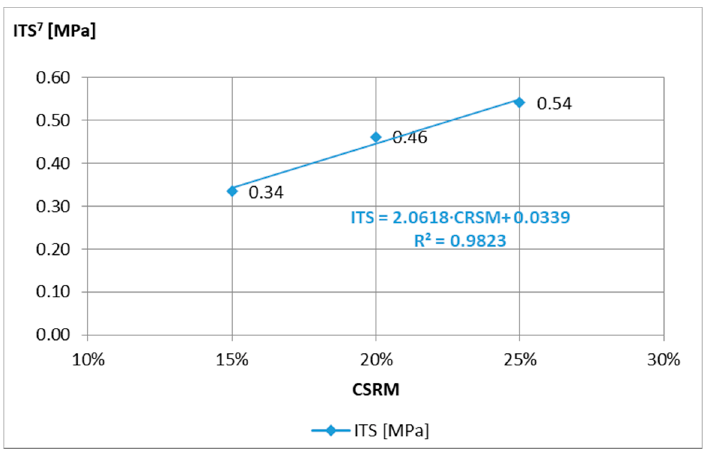
Figure 6. Indirect tensile strength ITS of samples Ø100 mm × 63.5 mm with ACCR depending on the amount of “B” CRS mortar, at the temperature of 5 °C, after 7 days of curing. Water resistance (Table 3) ACCR regardless of the amount of “B” CSR mortar is close to the limit ITSR ≥ 0.7. Table 3. ITSR water resistance of ACCR with B mortar samples Ø100 mm × 63.5 mm, tested at the temperature of 5 °C, after 28 days of curing. Amount of “B” CSR Mortar in the ACC (m/m) [%]